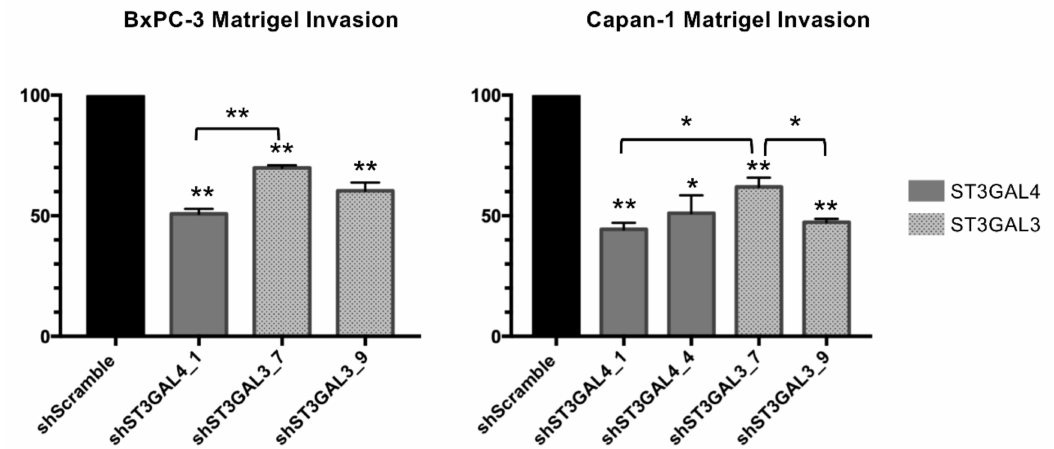
Figure 8. SLe x reduction impaired cell Matrigel invasion in vitro. Tumor cell invasion was evaluated using Boyden chambers in 24-well plates with Matrigel coated inserts. Invading capacity was assessed by quantifying the number of cells that invade in BxPC-3 knockdown (left) and Capan-1 knockdown cells (right) relative to scramble control cells. Data represent the mean ± SEM from at least 3 independent experiments. ANOVA and Tukey’s multiple comparison post-hoc test was performed. * p < 0.05, ** p <